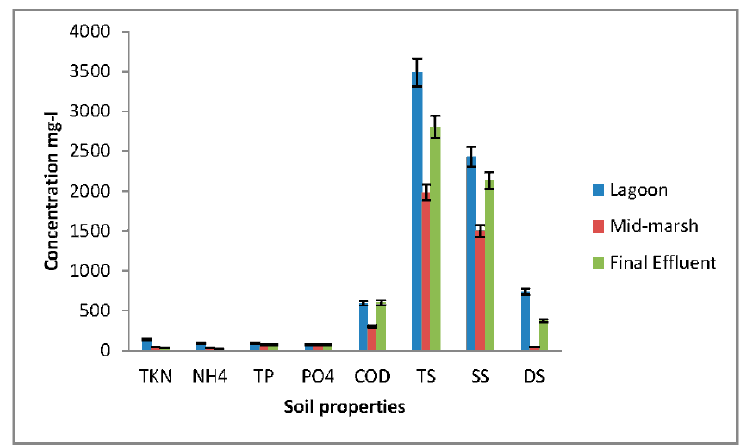
Figure 2. Nutrient removal in wetland samples collected in duplicate.